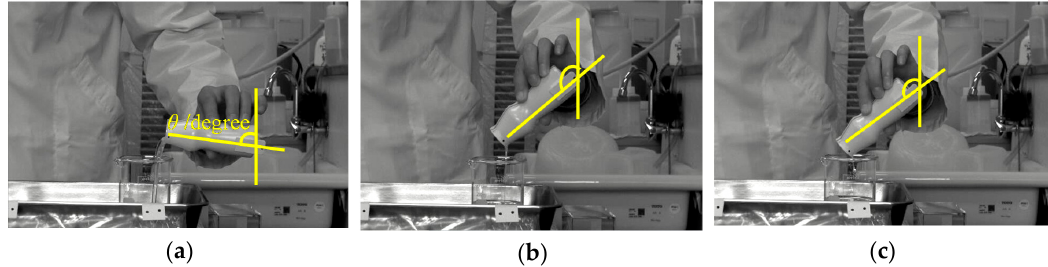
Figure 4. Image of the pouring process at 5, 10, and 15 s after a subject (ID14) poured the 3 wt% PEG500,000 aqueous solution ( d ) into a beaker: ( a ) The flowing state, ( b ) yarning state, and ( c ) dripping state. Yellow lines show measured angle of container during pouring process.